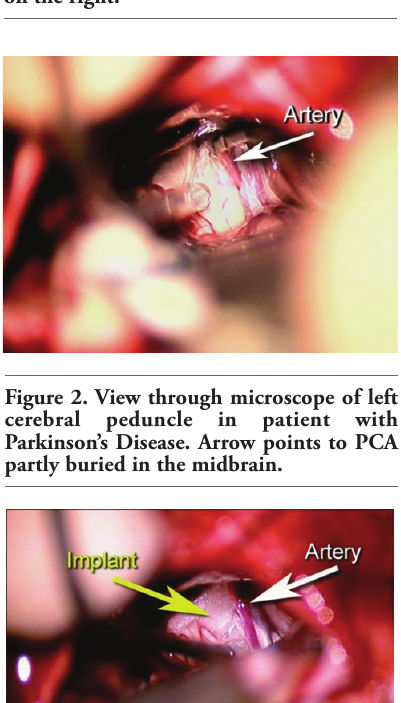
Figure 1. Magnetic resonance imaging scan T2 axial view at level of midbrain. Arrow points to area of compression of left cere- bral peduncle by posterior cerebral artery. Clear space filled with cerebral fluid is seen on the right.